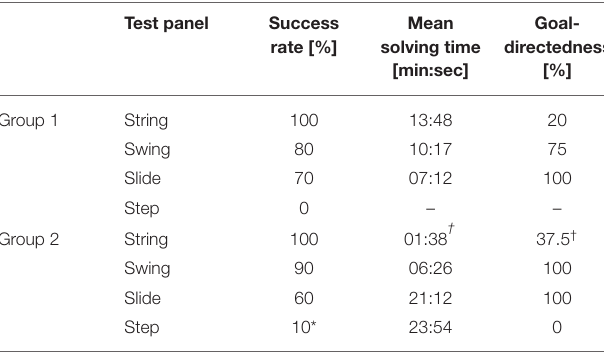
TABLE 1 | Overview of success rates, mean solving times, and goal-directedness in each